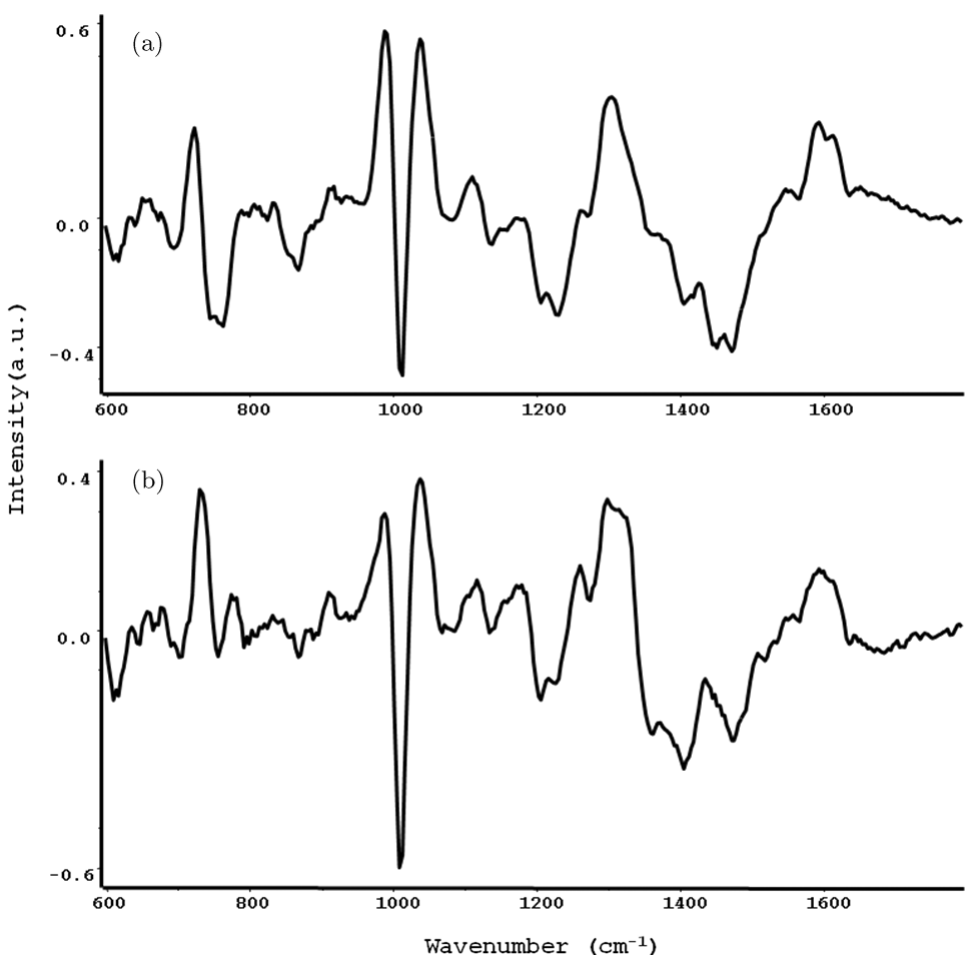
Fig. 7. Di®erence spectra for SERS approach. (a) Highest concentration (0.1 mg) — blank plasma, (b) Lowest concentration (1 (cid:1) g) — blank